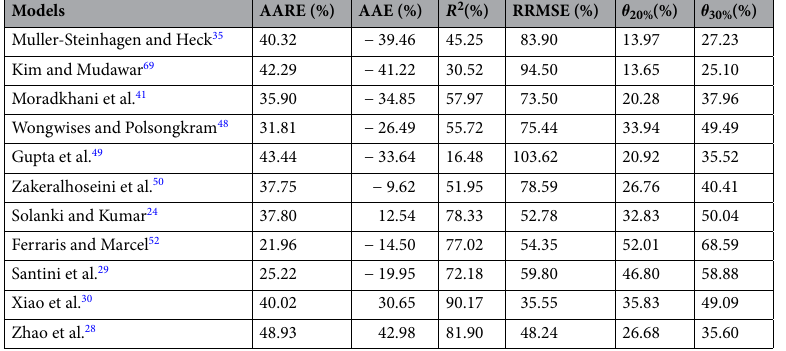
Table 4. Error metrics of the earlier models for predicting the two-phase FPD in coiled tubes.